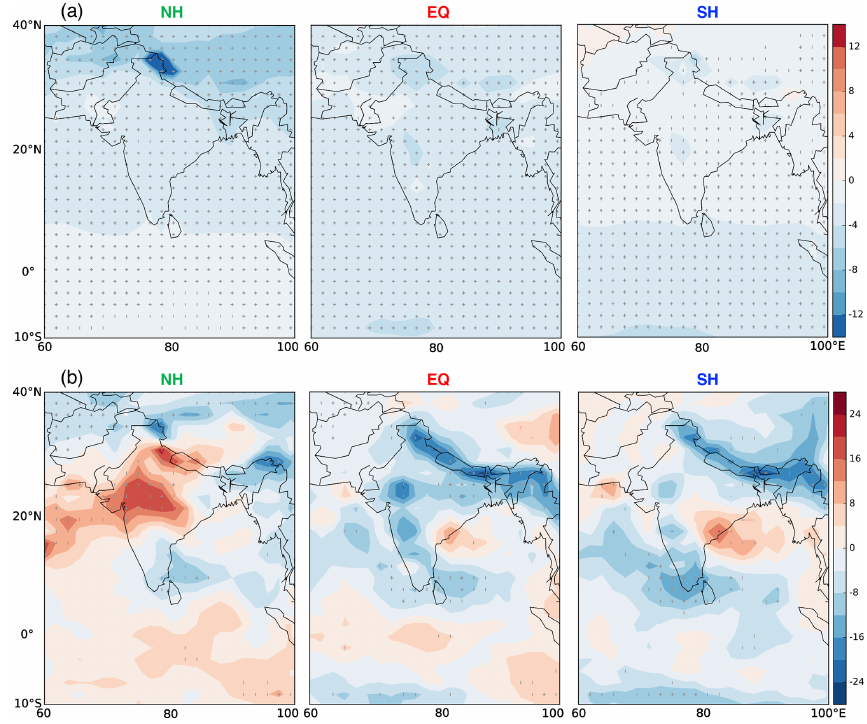
Figure 9. Spatial distribution of JJA mean net surface solar radiation (kgm − 2 ) anomaly in clear-sky (a) and all-sky conditions (b) after the NH (left), EQ (middle) and SH (right) volcanic eruptions in 1992. The vertical bars and plus signs indicate the grid points with significant differences based on the two-tailed Student’s t test at the 95% and 99% confidence level,